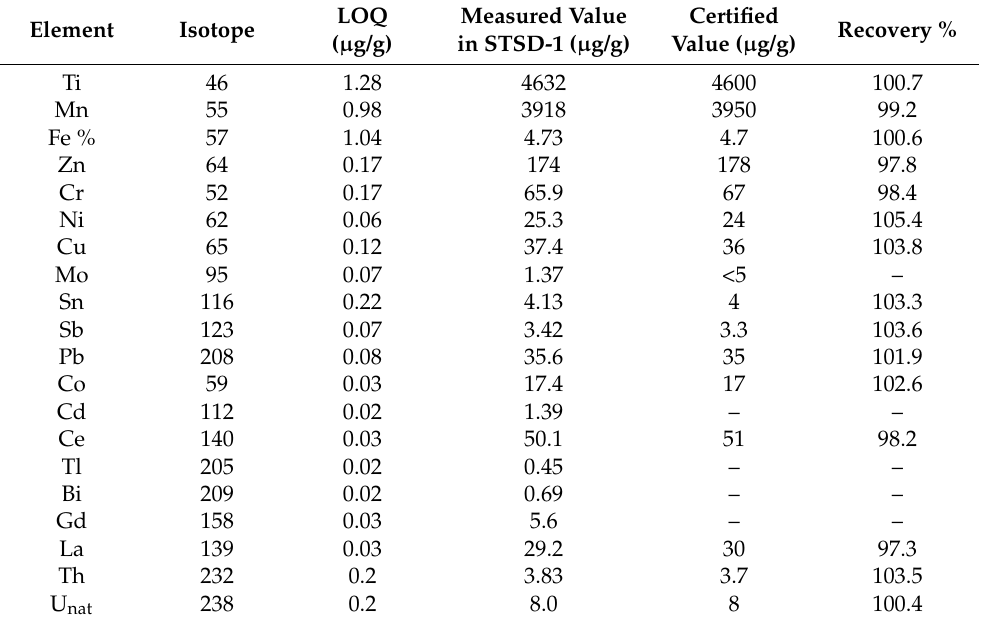
Table 7. Measured and certified values of the sediment certified reference material STSD-1.